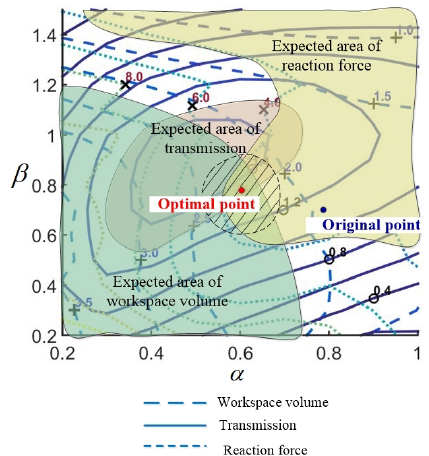
Figure 18. Contour map of overall performance.